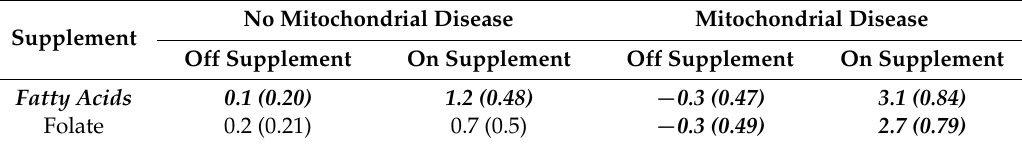
Table 3. Means (Standard Error) of Normalized Complex I activity on and off supplements by Mitochondrial Disease group. Supplements that are confirmed to be significant in the stepwise regression are bolded and italicized.